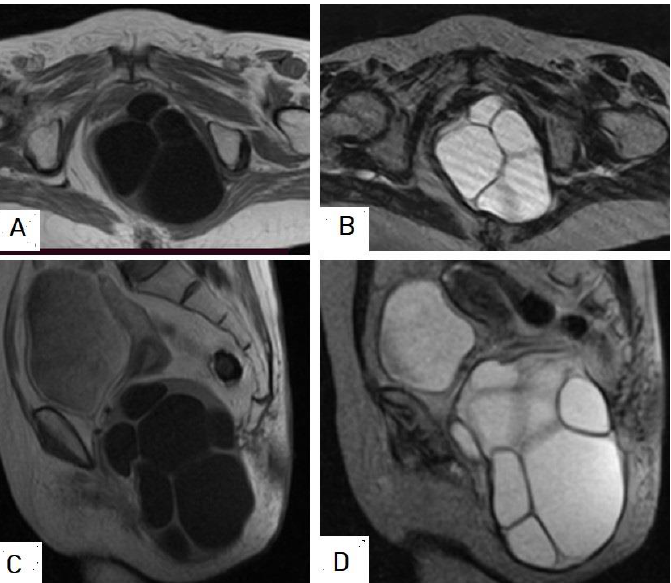
Figure 25. Selected images of pelvic MRI of a 75-year-old female presenting with pelvic pain, difficulty defecating, and micturition, which shows about a 12 × 9 cm well-circumscribed, multiloculated cystic lesion in the left presacral and paranal, with ischiorectal fossa causing mass effect in the form of displacing the anal canal and rectum to the right side. The lesion appears hypointense on axial and sagittal T1-weighted images ( A , C ), and hyperintense on axial and sagittal T2-weighted images ( B , D ), with multiple cysts inside it, which is a typical picture of an intramuscular hydatid cyst.